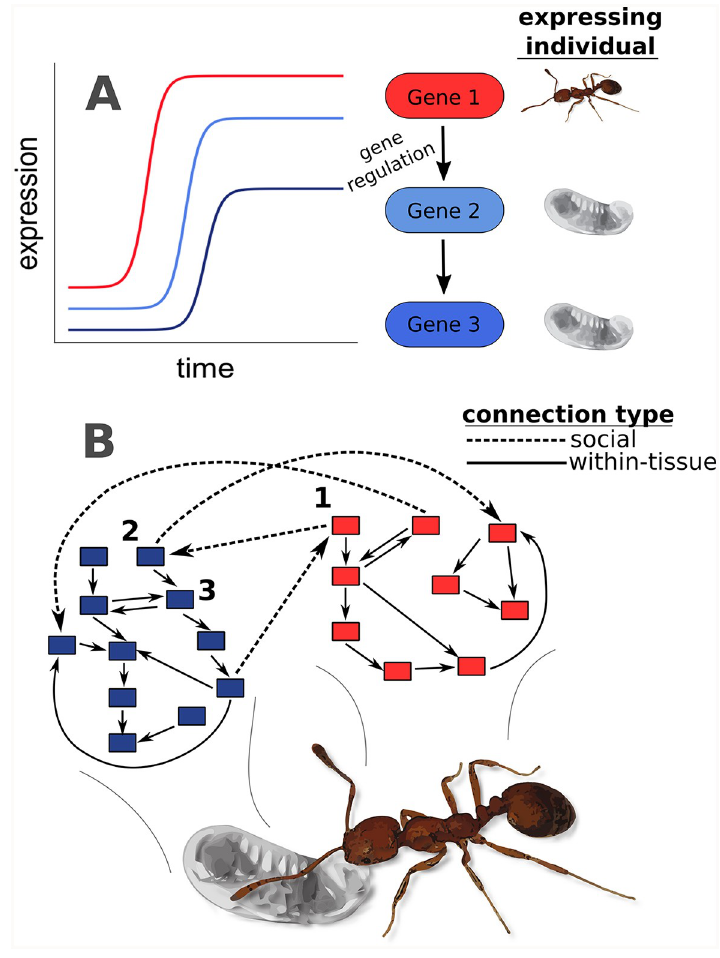
Fig 1. Social regulation of gene expression between ant nurses and larvae. (A) Cartoon depicting positive gene regulation (i.e. activation) between larvae and nurses, where gene 1 is expressed in nurses and genes 2 and 3 are expressed in larvae. After the expression of gene 1 increases, the expression of gene 2 increases as a result of the social interaction of nursing (depicted in [B]). This can occur if gene 1 itself codes for a protein passed to larvae, if the mRNA transcript is passed directly, or if gene 1 activates the expression of some other gene in nurses, which in turn is passed as mRNA (or codes for a protein that is passed) to larvae. Following the increase in expression of gene 2, the expression of gene 3, which is shown to be activated by gene 2, also increases. While we have depicted a time-lag in this social regulation of gene expression, the time lags are likely too short to observe in our data, as larvae were collected every 3–4 days across development. Therefore, correlated transcriptome dynamics over development (see Fig 2) would reflect mechanisms shown here. (B) Gene regulatory networks act between and within individuals engaged in social interactions. Blue boxes are genes expressed in larvae, and red boxes are genes expressed in nurses. Solid lines depict regulatory interactions within tissues (here, within larvae or within nurses), while dashed lines represent social connections (nurse-larva or vice